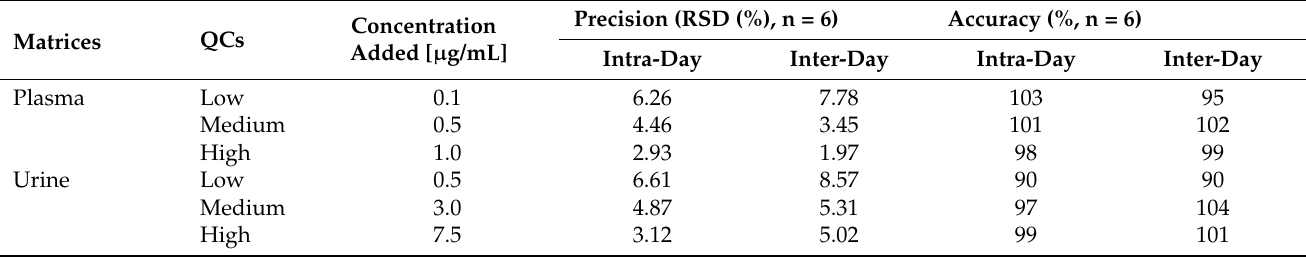
Table 1. Intra and inter-day precision and accuracy data for the QC samples (n =